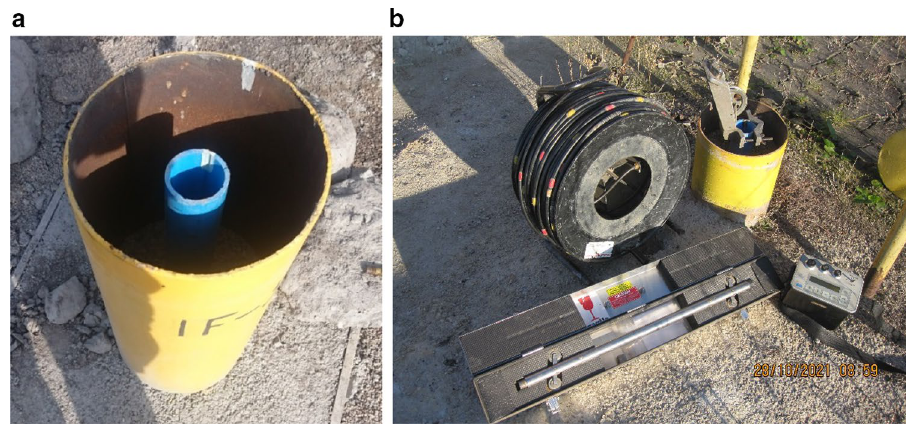
Fig. 1 a Inclinometer tube; b Deep displacement measurement kit (photographic materials of Geological Department—PGE GiEK S.A. Branch KWB